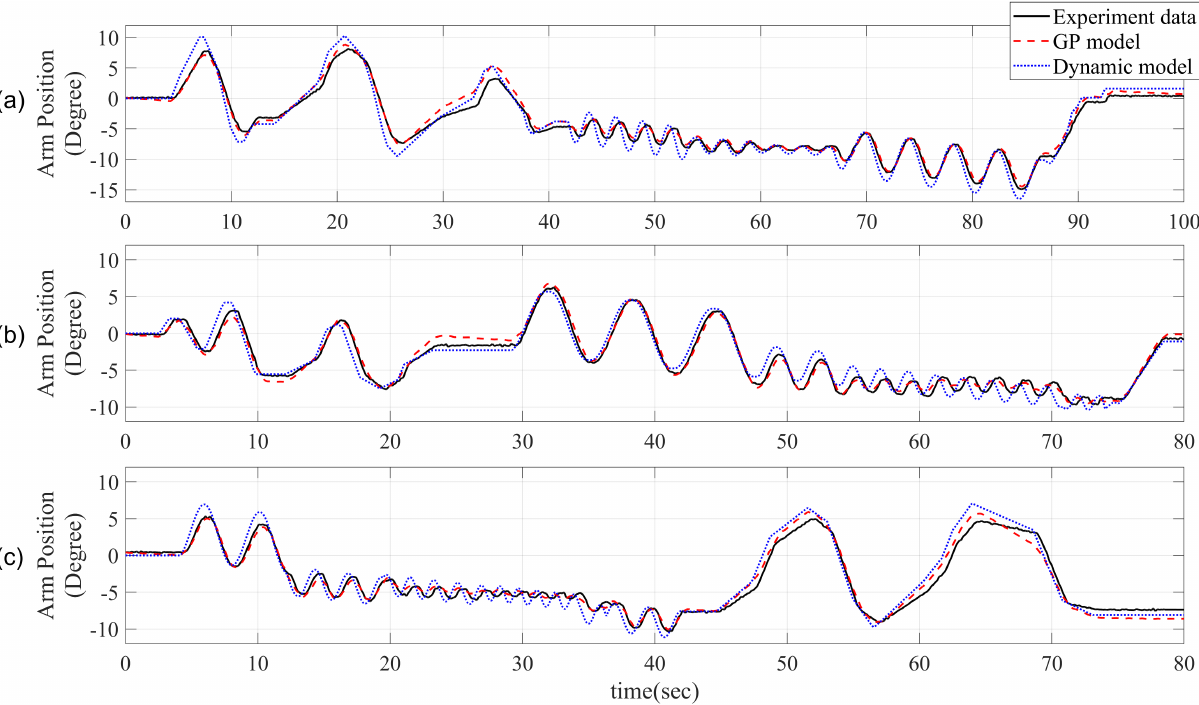
Figure 11. Arm position obtained using experiment, GP model, and dynamic models for ( a ) first validation input command set, ( b ) second validation input command set, and ( c ) third validation input command